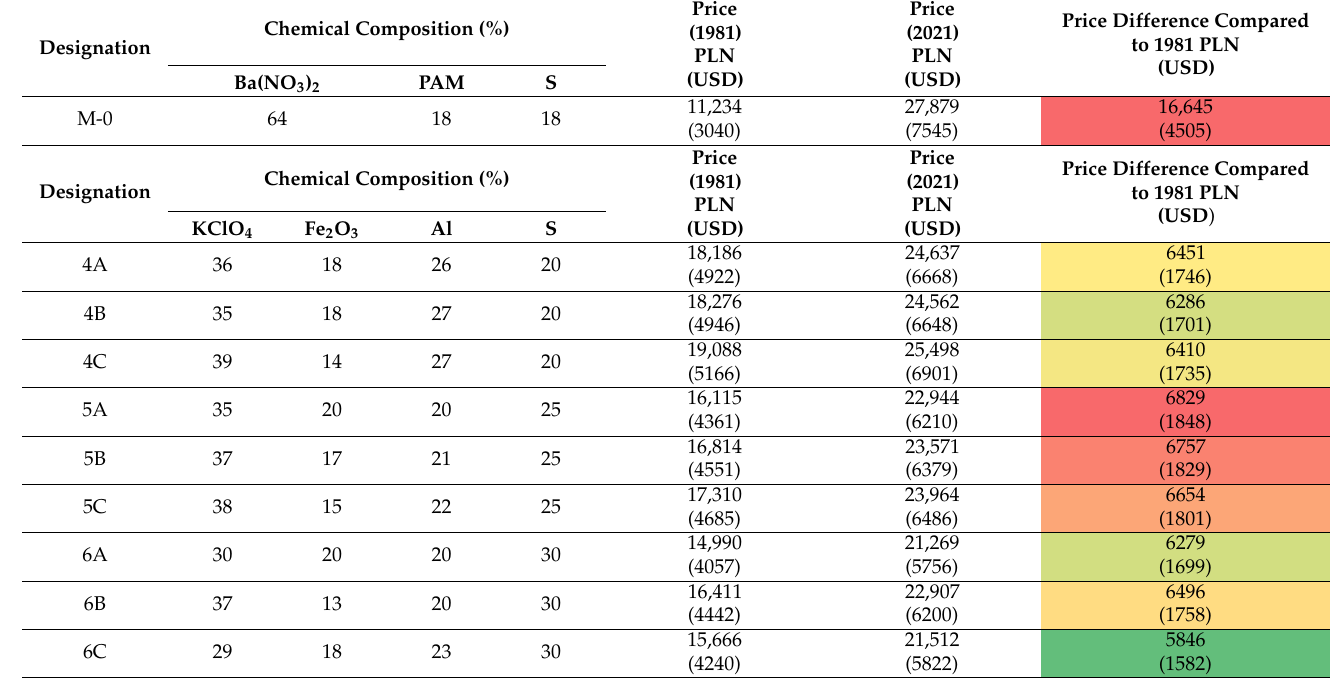
Table 10. Comparison of manufacturing costs of pyrotechnic compositions from the M-2 group for model 1, batch of 500 kg (1102 lb) of pyrotechnic